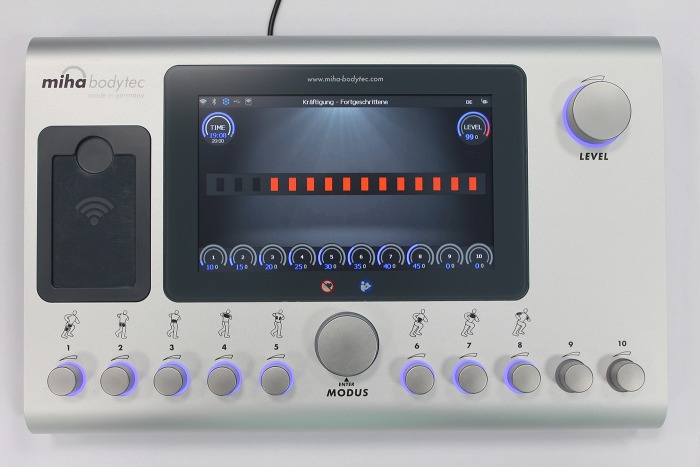
WB-EMS device miha bodytec 2.